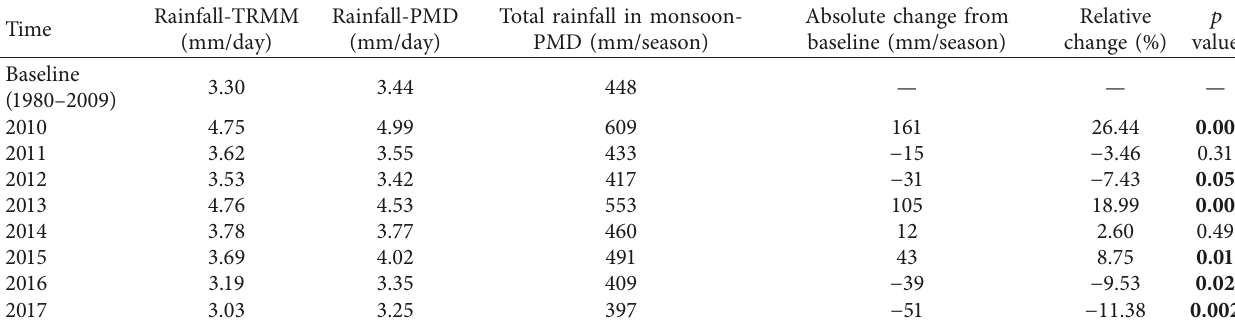
Table 3: Variability of monsoon rainfall from baseline